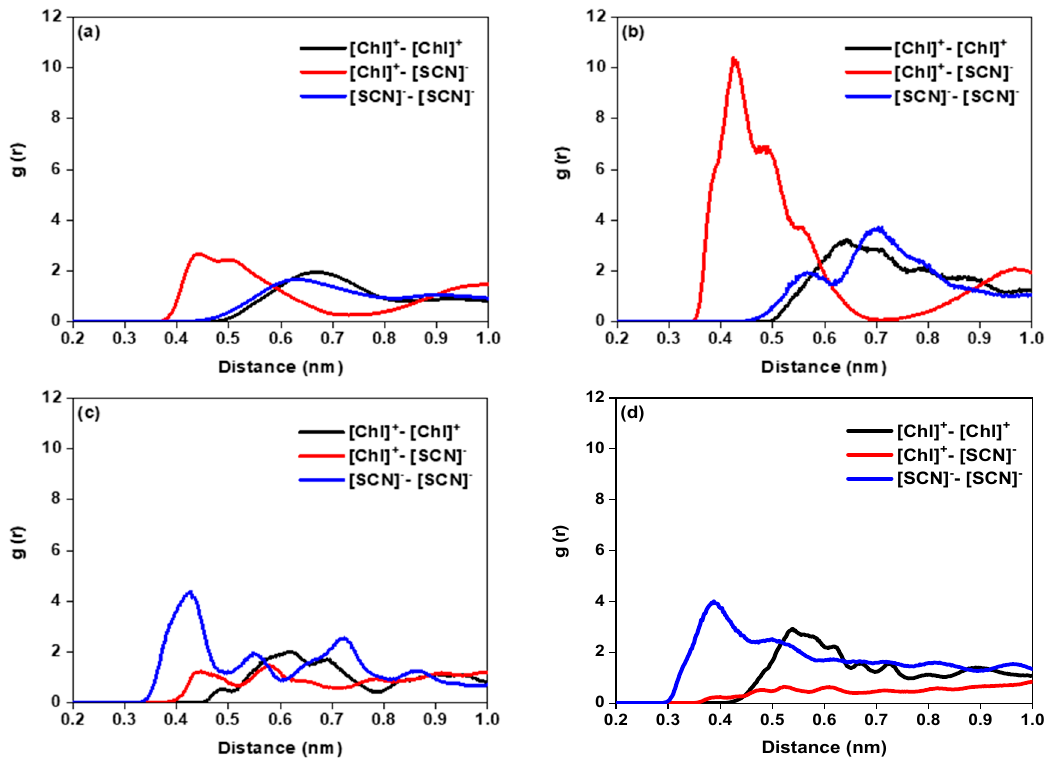
Figure 2. Radial distribution function (RDF) of [Chl]+ and [SCN] − in ( a ) the bulk phase, ( b ) 0.4% w / w , ( c ) 0.8% w / w , and ( d ) 1.2% w / w of IL loading in [Chl][SCN]/IRMOF-1 composites at 298 K and 1 atm.